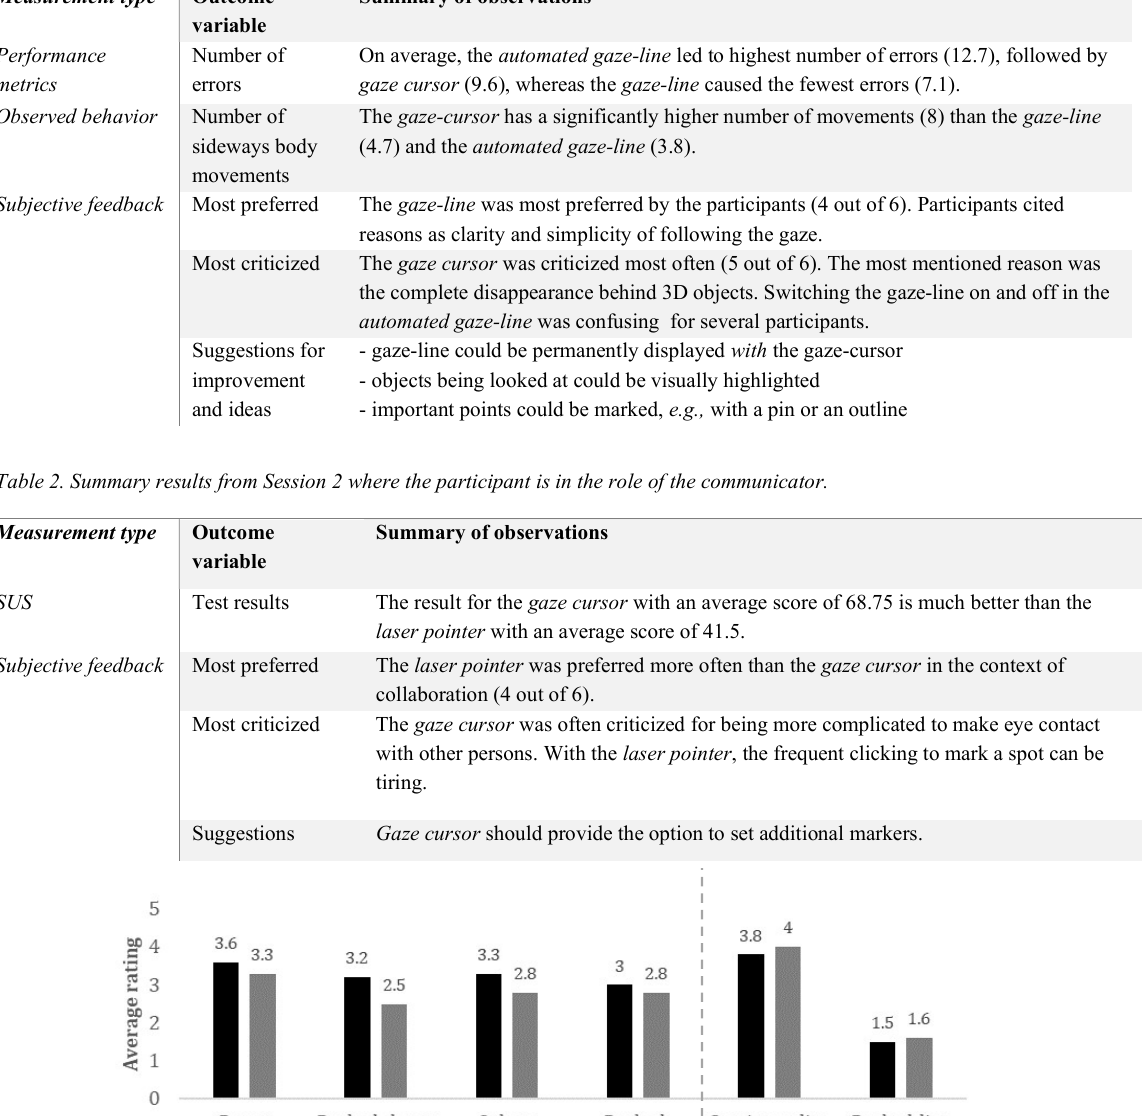
Table 1. Summary results from Session 1 where the participant is in the role of the recipient. Measurement type